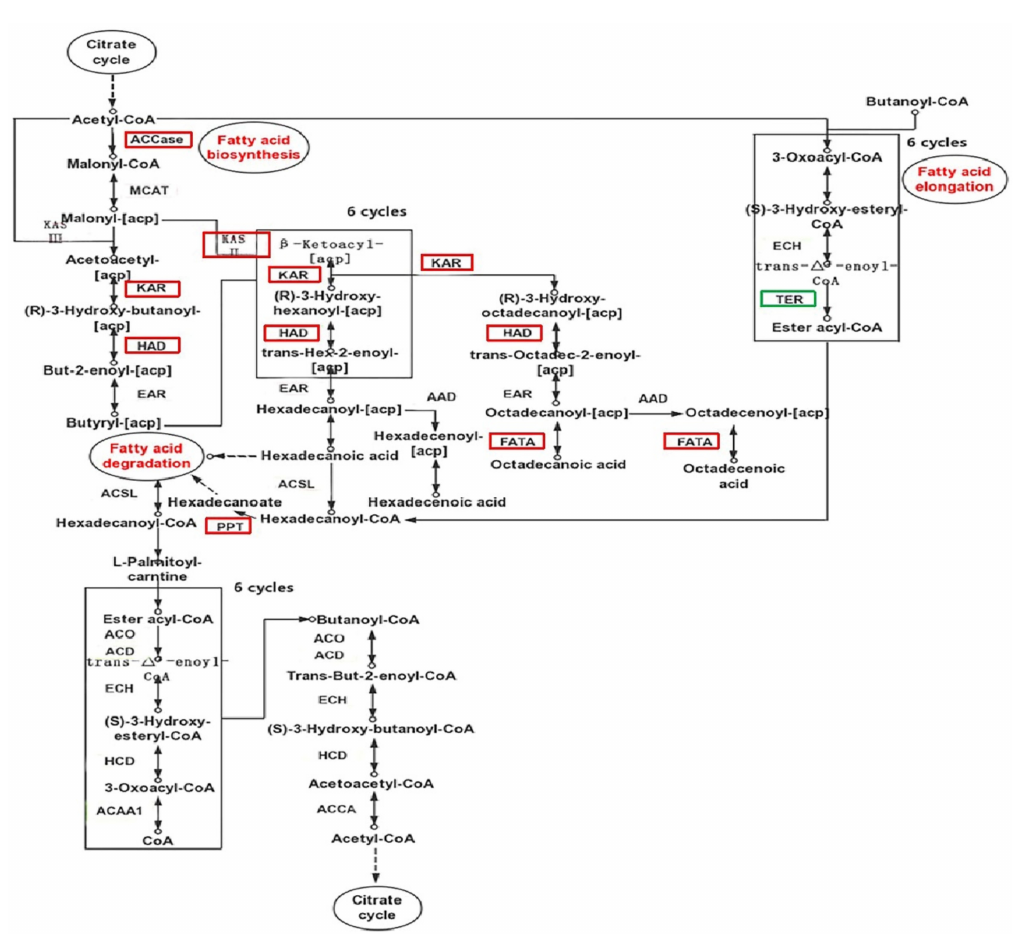
Figure 9. Schematic diagram of fatty acid metabolic pathways. The red boxes represent up-regulated genes under high-salt condition; the green boxes represent down-regulated genes under high-salt